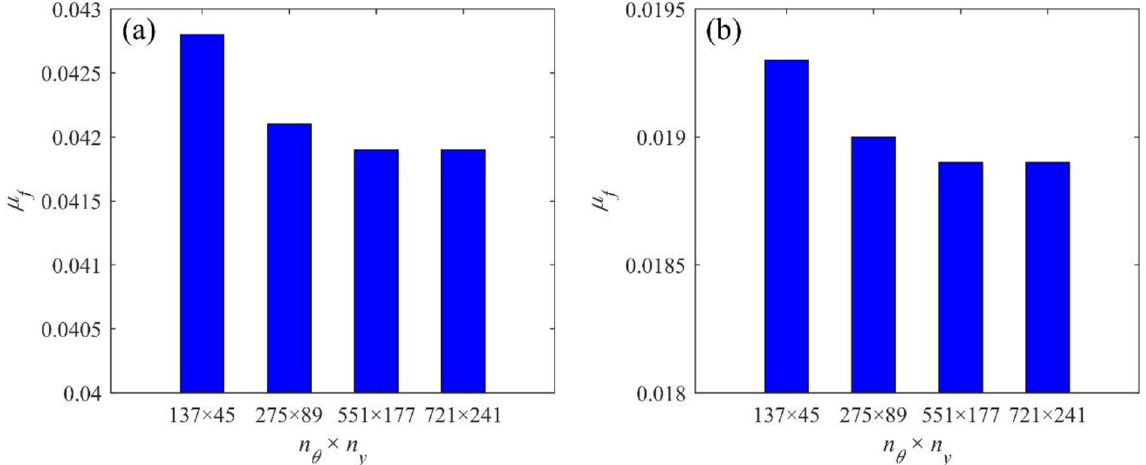
Fig. 4. Friction coef fi cients m f of different mesh schemes under (a) e =0.2, (b) e = 0.4.